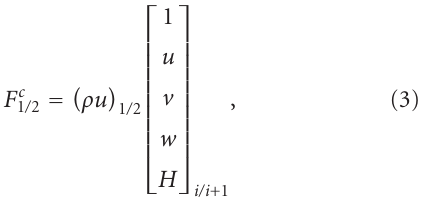
Figure 2: Longitudinal cut view of the grid system.